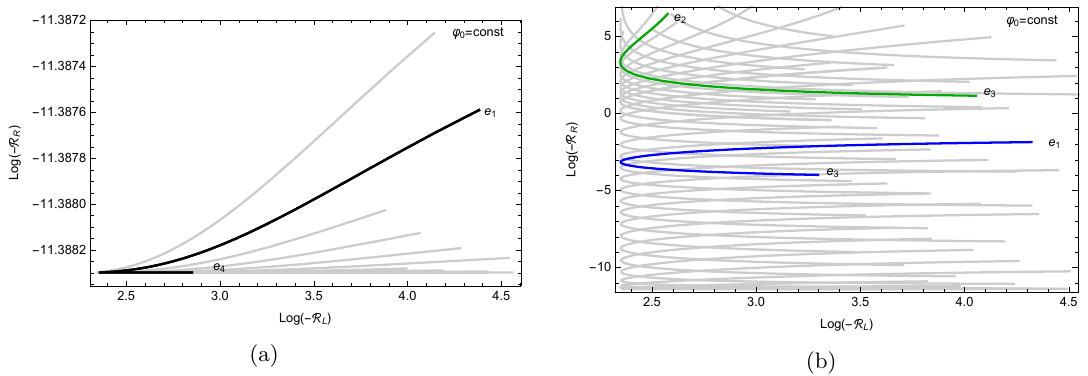
solutions at fixed ϕ . In figure (a) all curves belong to the Figure 30 . R R vs R L for the W LR 0 1 , 1 points between e and e boundaries in figure 28a. In figure (b) curves are sketched either between 1 4 e 1 and e 4 boundaries (e.g. the blue curve at ϕ 0 = 4 ) or between e 2 and e 3 boundaries (e.g. the green curve at ϕ = 4 . 245 ). 0